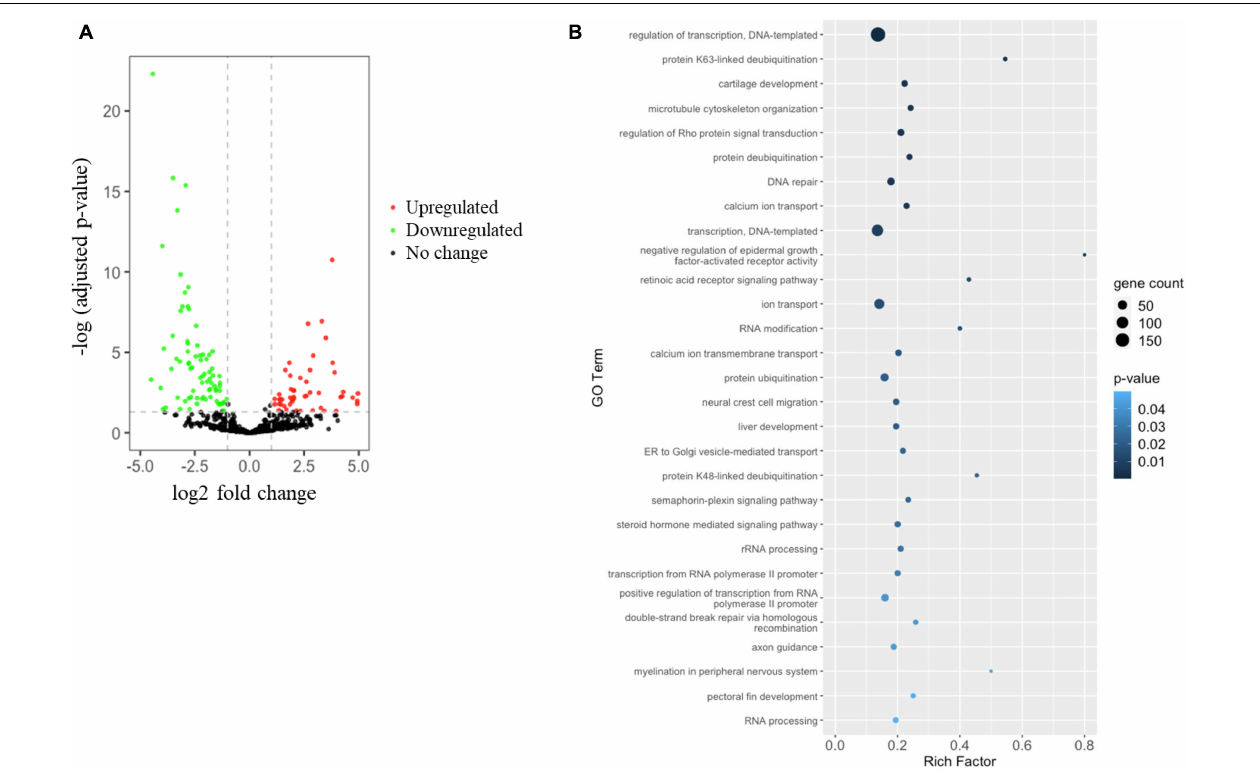
FIGURE 2 | Hypoxia induces miRNA dysregulation, leading to altered medaka embryonic development. (A) Volcano plot indicating differential miRNA expression in medaka embryos after hypoxia or normoxia exposure. miRNA with | log2 (fold change: hypoxia/normoxia)| > 1 and –log B&H corrected p -value > 1.3 were considered differentially expressed. Red dots represent upregulated miRNA, green dots represent downregulated miRNA, and black dots represent miRNA with no significant change. (B) Rich factor plot showing the biological processes altered by the miRNAs target predicted by Gene Ontology (GO) enrichment analysis of Database for Annotation, Visualization and Integrated Discovery (DAVID). Dot size represents the number of target genes. The color intensity of each dot represents the significance of the biological